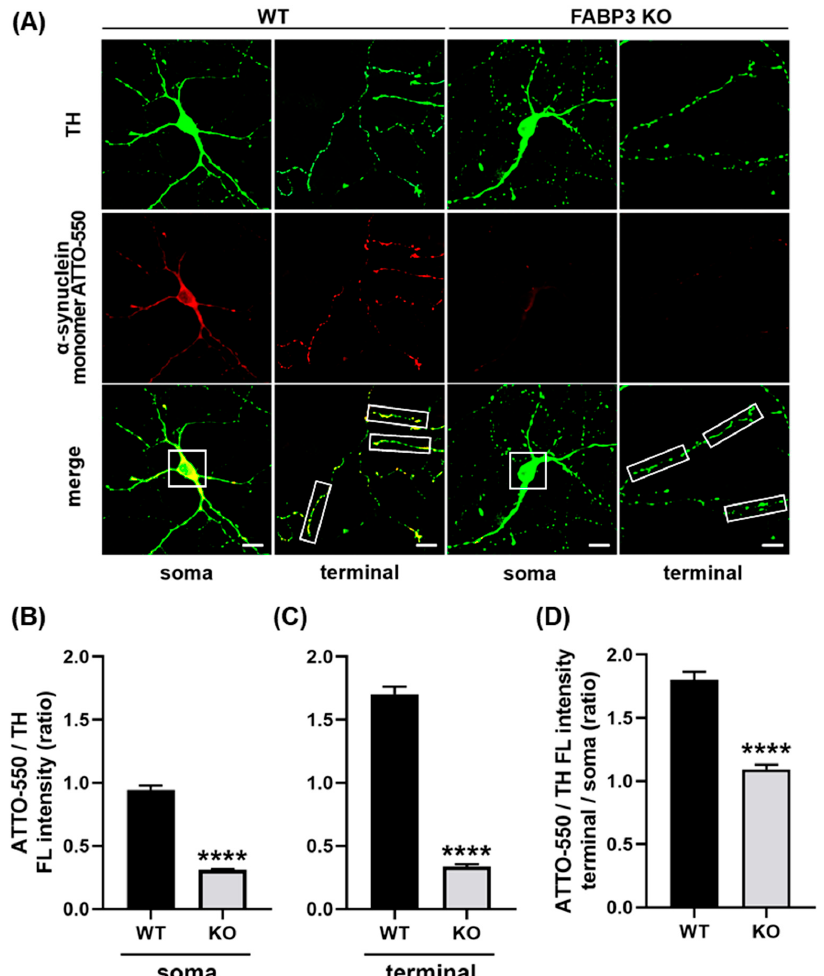
Figure 1. Cultured primary dopaminergic neurons require fatty acid-binding protein 3 (FABP3)